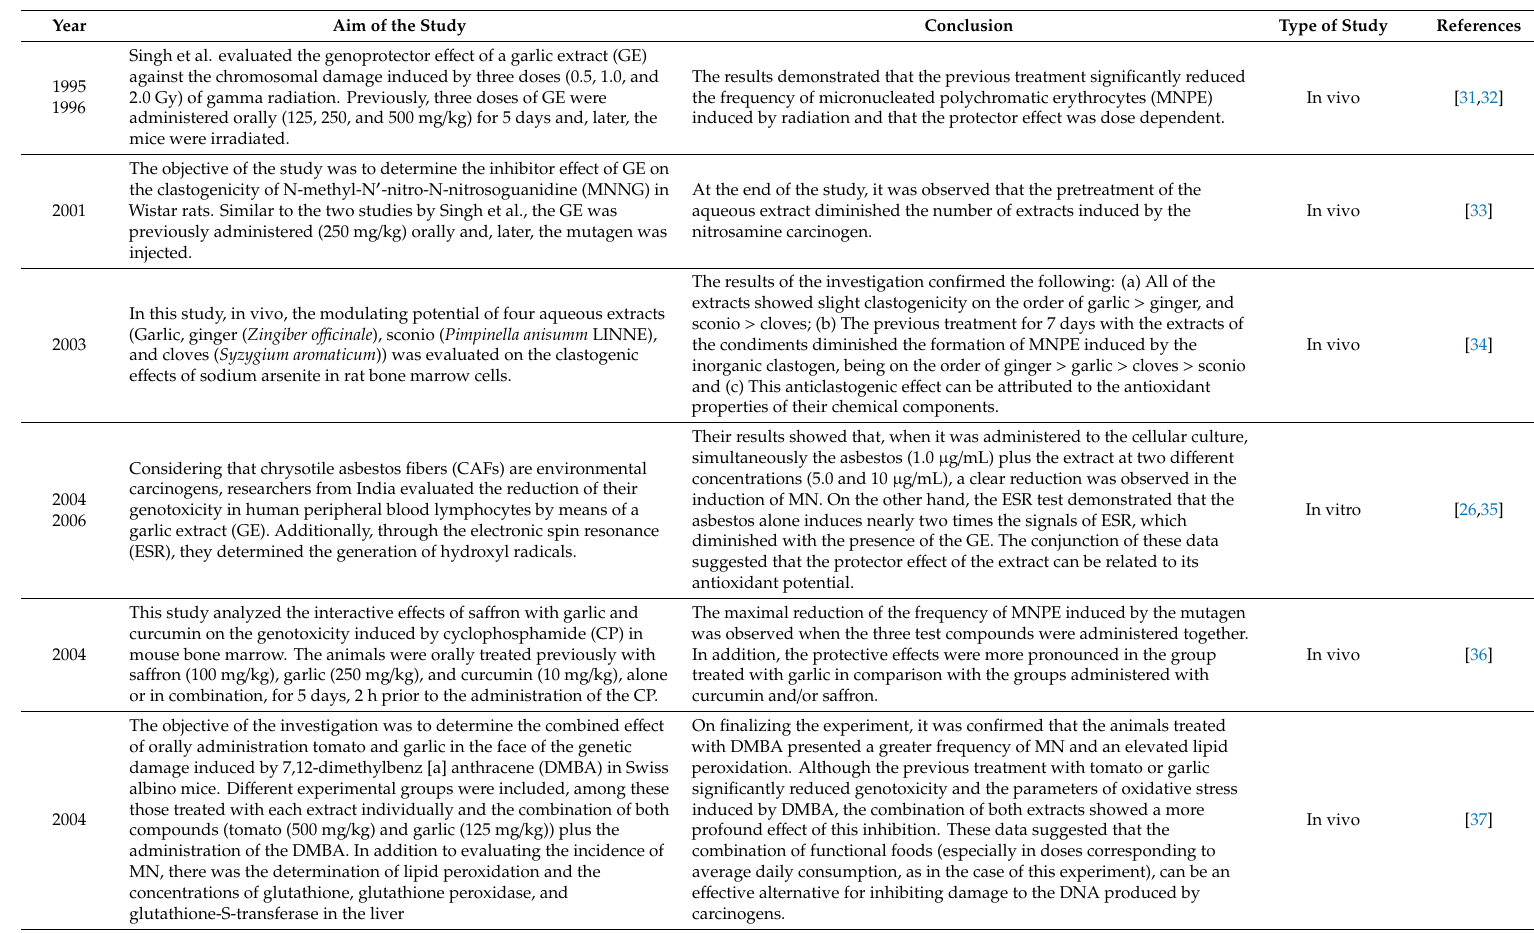
Table 2. Studies carried out with the micronucleus (MN) assay that evaluate the antigenotoxic e ff ect of